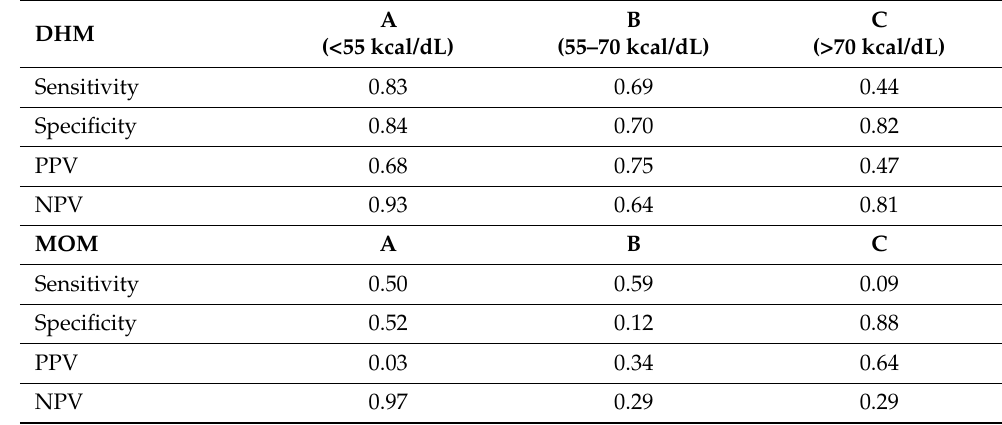
Figure 3. Average calories with data scatter in each color category. The x -axis represents the milk samples color-matched and coded as A, B, or C categories. The y -axis represents the calorie value of human milk as measured by the human milk analyzer. DHM A, B, and C, category mean calories = 52, 65, and 70 kcal/100 mL, respectively; MOM A, B, and C category mean calories = 73, 76, and 77 kcal/dL, respectively. Table 2. Diagnostic ability of HMCG tool for predicting HM calorie ranges.